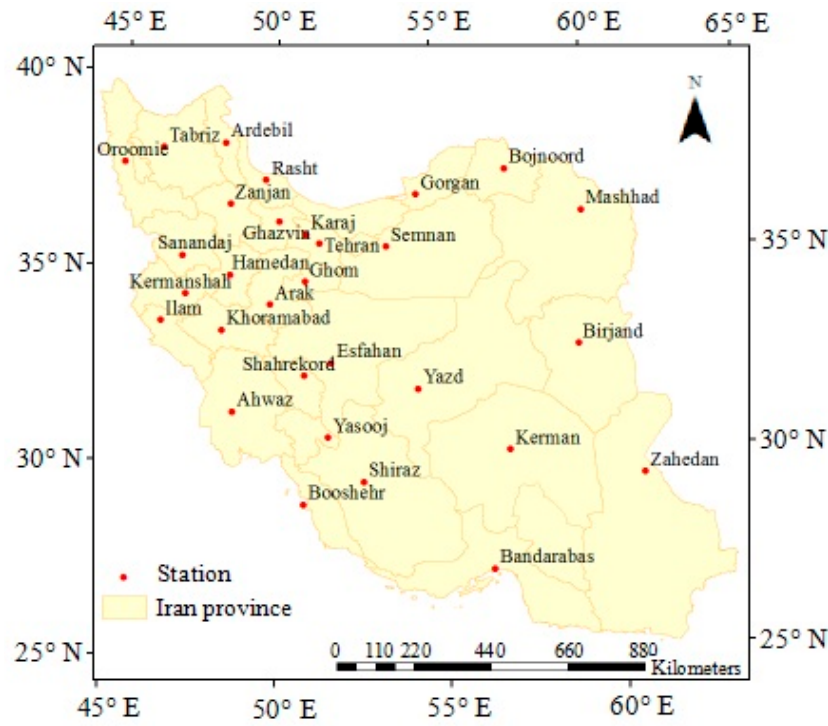
Figure 1. Geographical location of the selected stations in Iran.